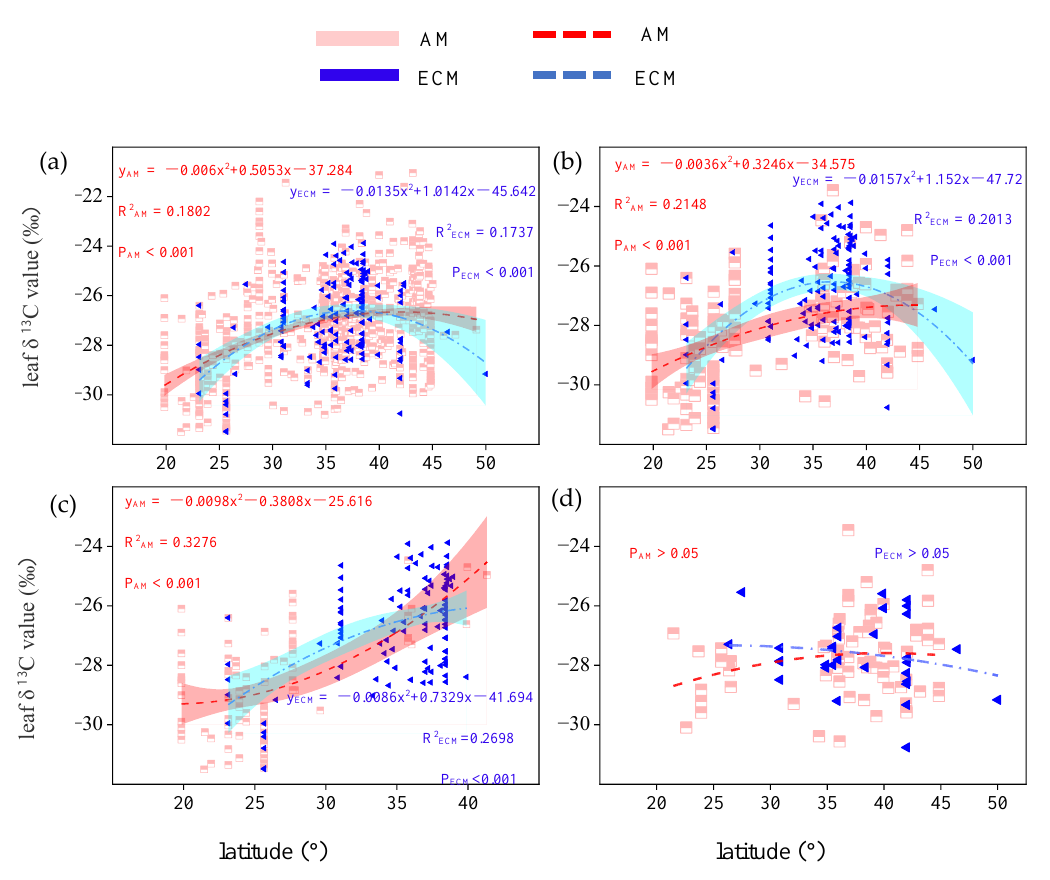
Figure 3. Variation of leaf δ 13 C in AM plants and ECM plants with different life forms along latitude. ( a ) Total plants, include all plants in the database without distinguishing their life forms ( b ) trees, only contain all the tree species in the database ( c ) evergreen trees, only contain all evergreen trees of the tree species. ( d ) deciduous trees, only contain all deciduous trees of the tree species. The red broken line means AM, the blue broken line means ECM. The red and cyan bands represent, respectively, the prediction intervals of AM and ECM plants.